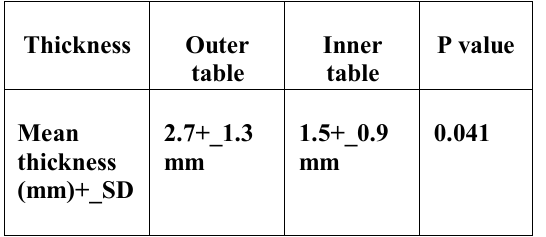
Table 3: Comparison of overall mean thickness of Outer and Inner tables of calvarium